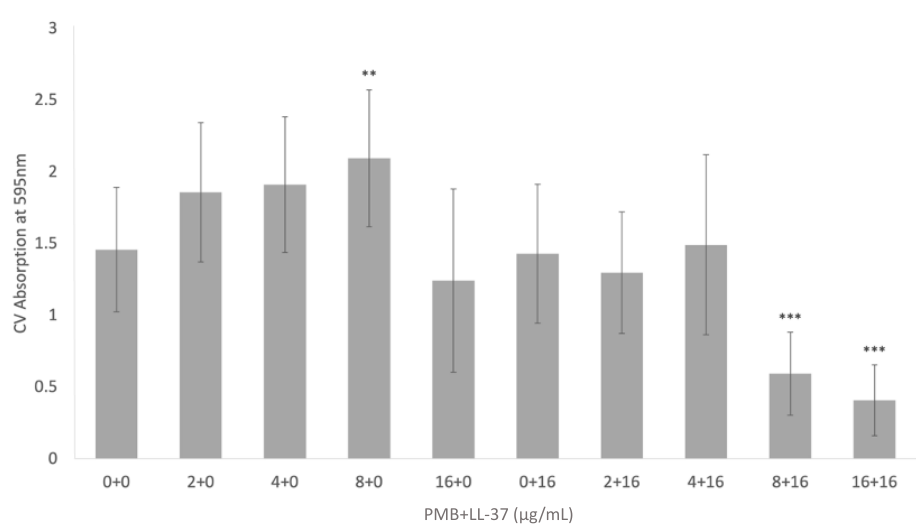
Figure 5. Eradication of E. coli MG1655 pre-grown biofilms treated with PMB, LL-37, and the PMB + LL-37 combination treatment. The ability of PMB, alone and in combination with LL-37, to eradicate E. coli MG1655 biofilm growth was evaluated via crystal violet staining. E. coli MG1655 biofilms were grown in a 96-well microtiter plate at 37 °C for 24 h. Pre-grown biofilms were treated with varying concentrations of PMB (0 μ g/mL, 2 μ g/mL, 4 μ g/mL, 8 μ g/mL, and 16 μ g/mL), LL-37 (0 μ g/mL and 16 μ g/mL) and the PMB + LL-37 combination (2 μ g/mL PMB + 16 μ g/mL LL-37, 4 μ g/mL PMB + 16 μ g/mL LL-37, 8 μ g/mL PMB + 16 μ g/mL LL-37, and 16 μ g/mL PMB + 16 μ g/mL LL-37).